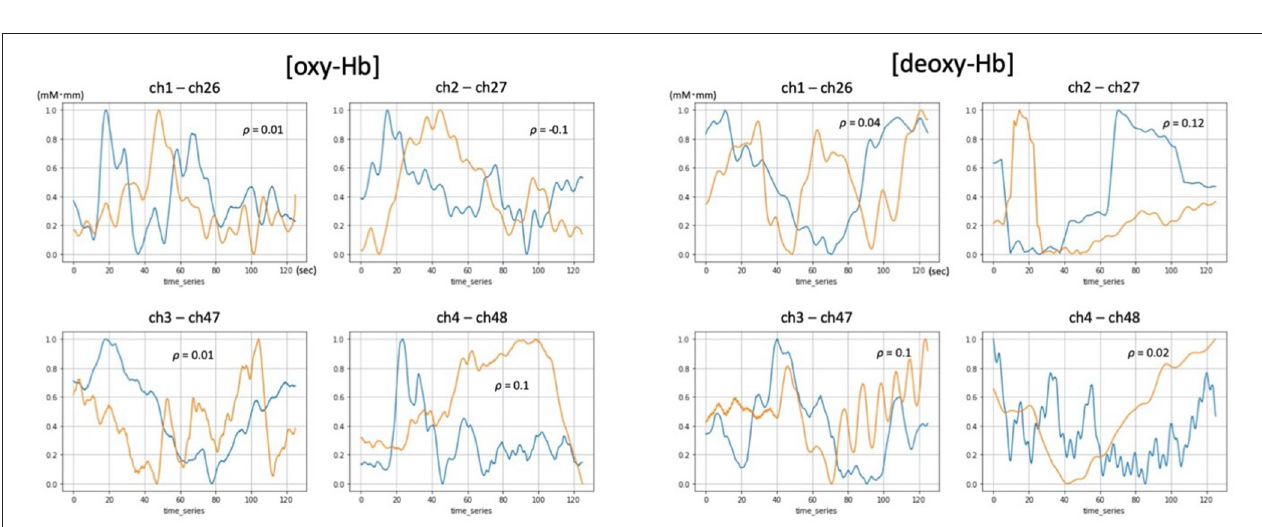
FIGURE 3 | Examples of [oxy-Hb] and [deoxy-Hb] time courses demonstrating low correlation between 52ch-NIRS and cNIRS. Blue and orange lines represent time course changes during the verbal fluency task (VFT) detected by 52ch-NIRS and cNIRS, respectively. For each of the four cNIRS and 52ch-NIRS channel pairs (ch1/ch26, ch2/ch27, ch3/ch47, and ch4/ch48), each member of the pair exhibited quite distinct [oxy-Hb] and [deoxy-Hb] activation patterns. Transformed Hb-values (mM mm) ranged from 0 to 1 and are displayed for visualization purposes (the data were transformed using a minimum-maximum scaler, which converted the minimum value to 0 and the maximum value to 1 for each